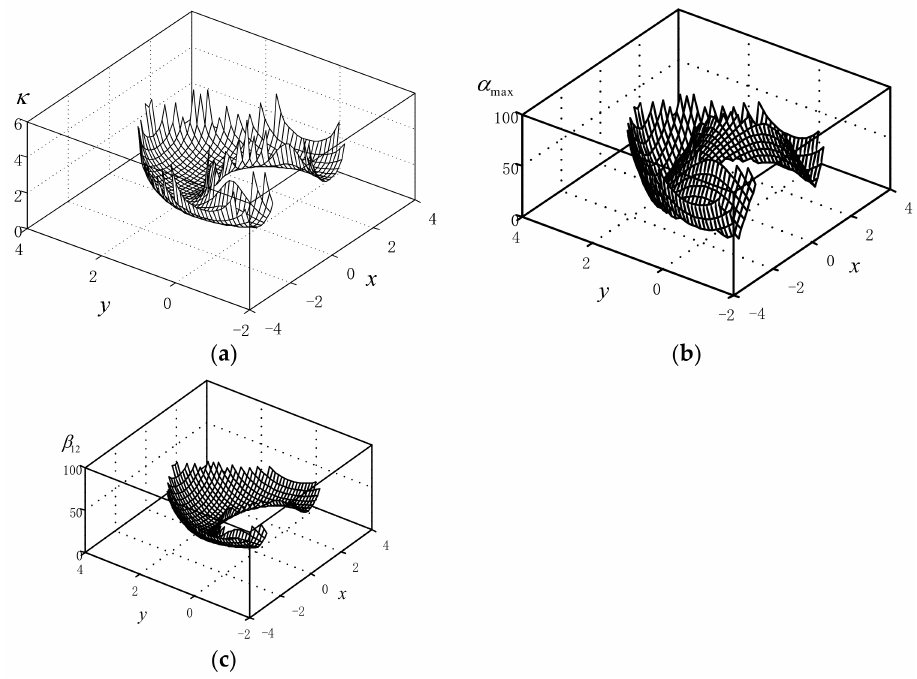
Figure 5. Variations in κ , ITA- α max and CTA in bounded workspace. ( a ) κ ; ( b ) ITA— α max = max ( α 1 α 2 ) ; ( c ) CTA in workspace bounded by κ 0 =